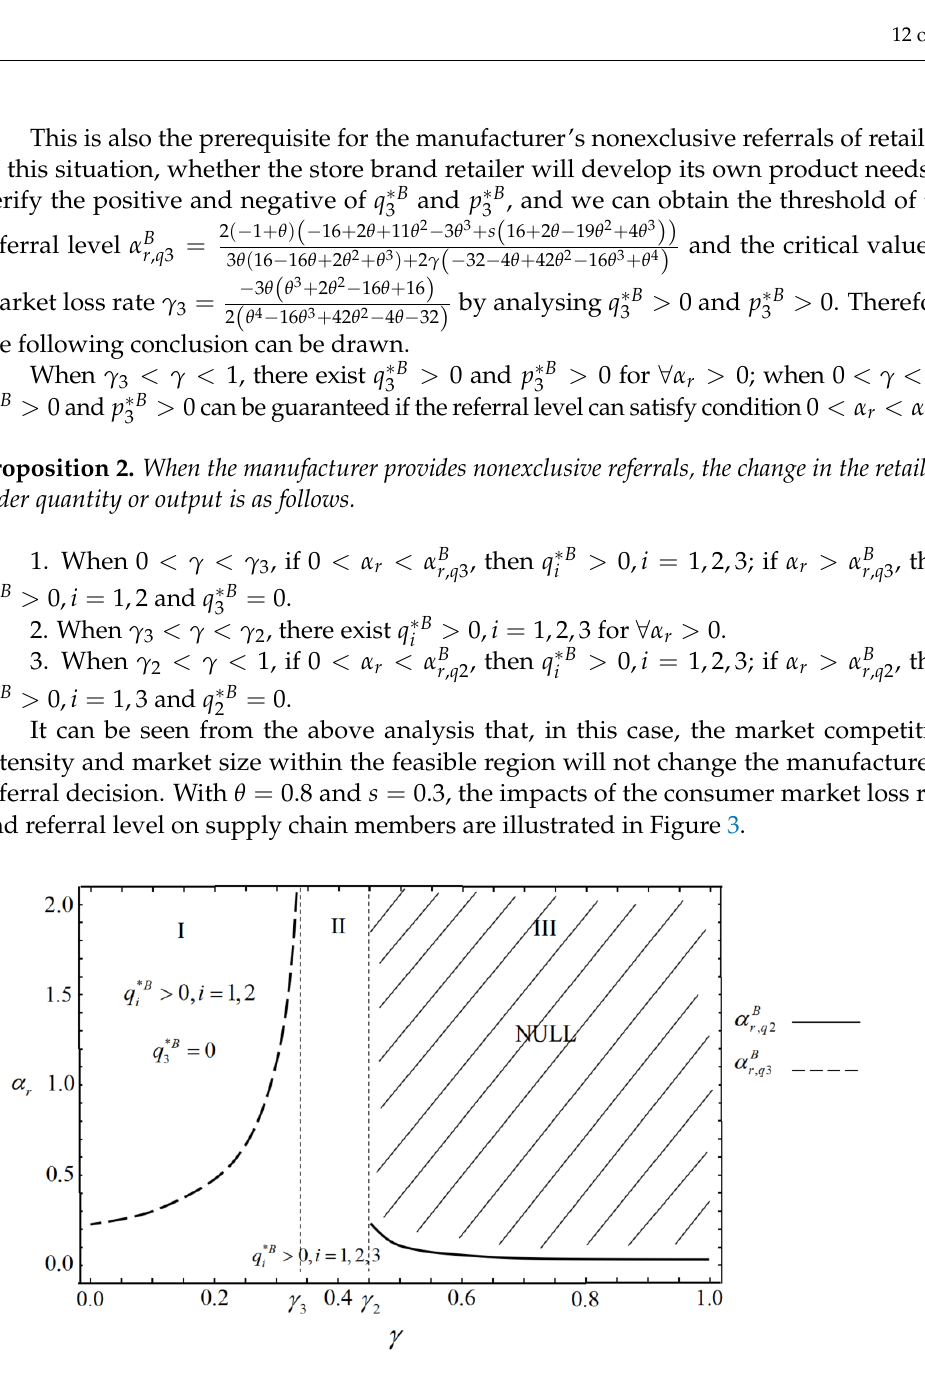
Figure 3. The impact of consumer market loss rate and referral level on supply chain members.